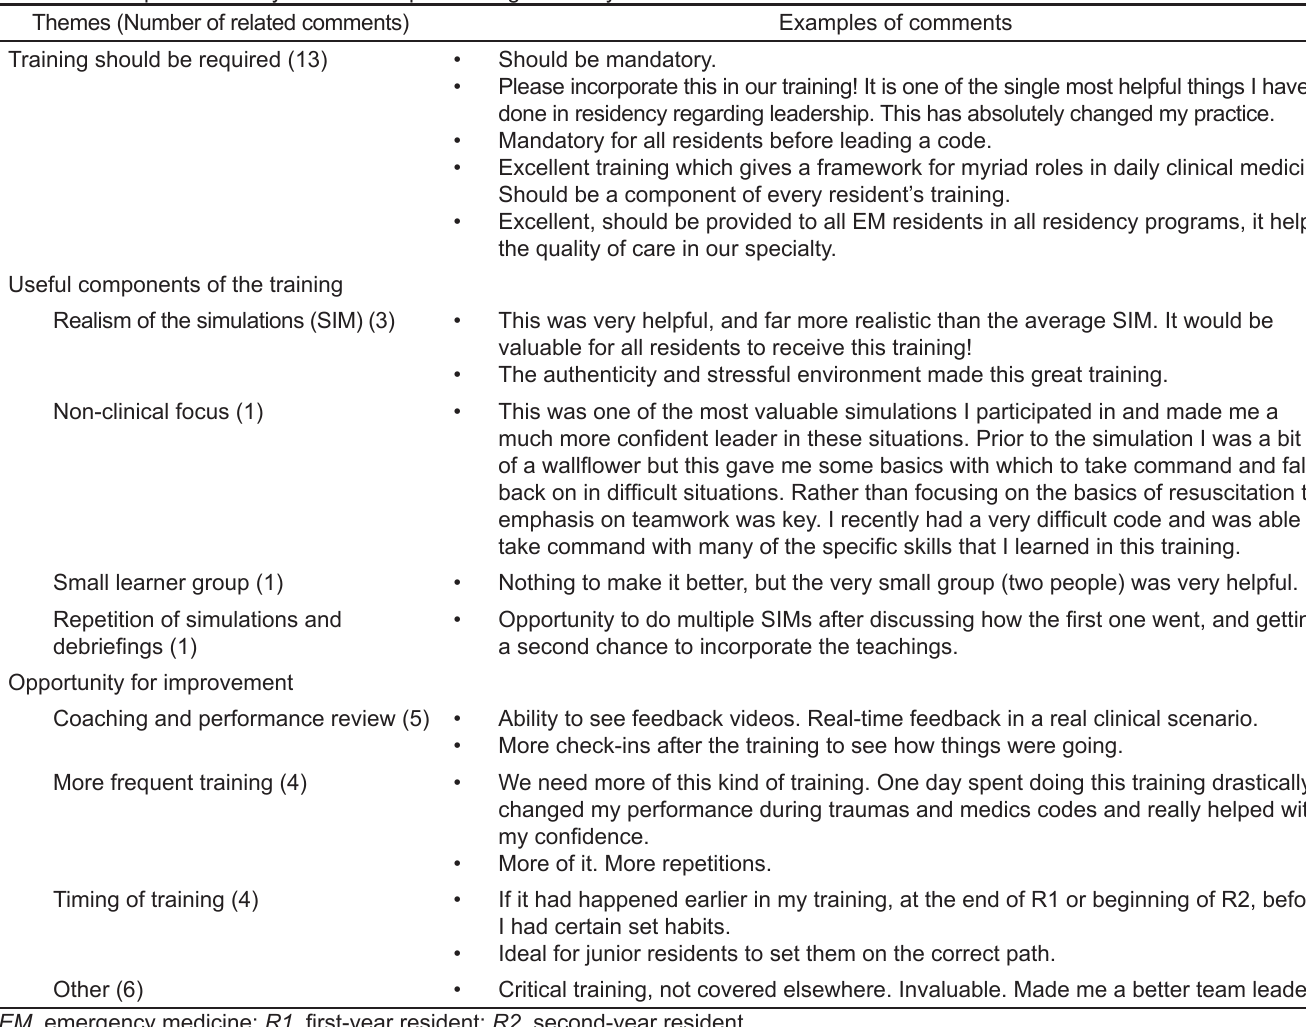
Table 4. Examples of survey free-text responses organized by